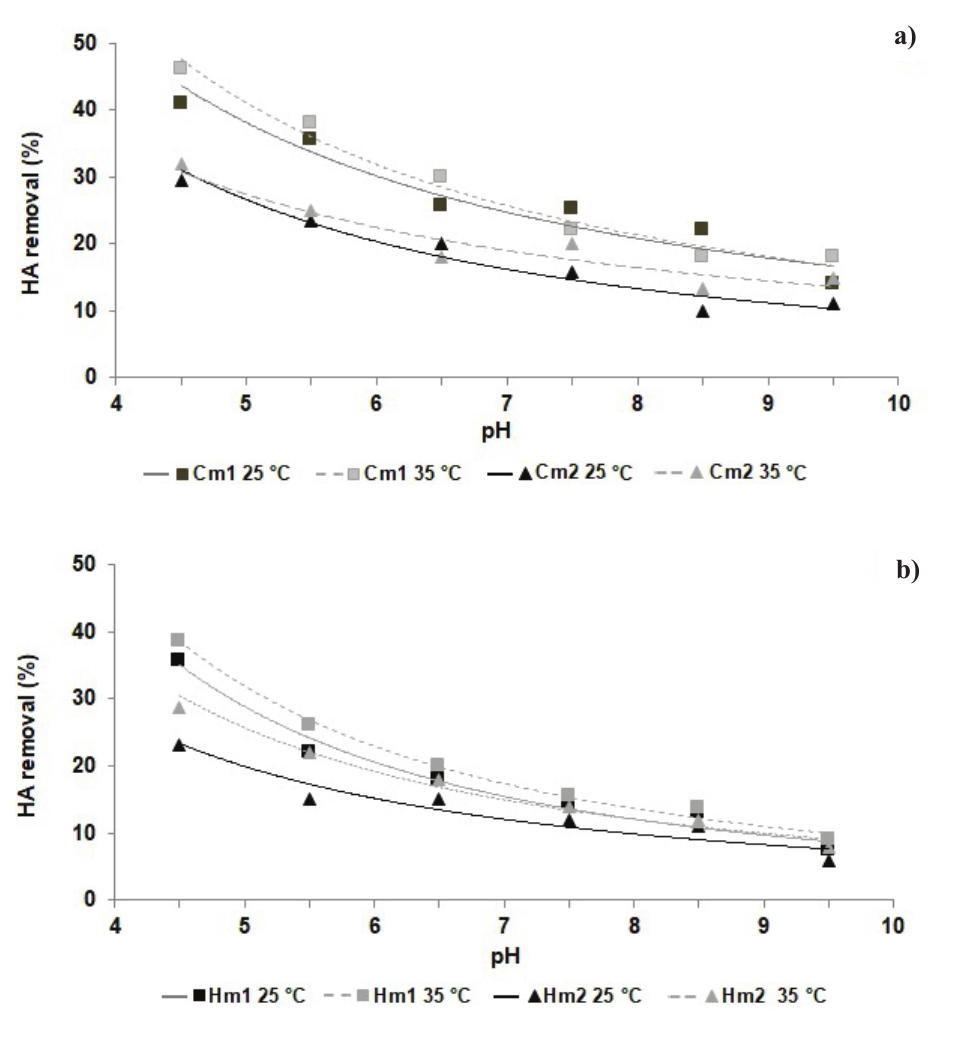
Fig. 5 – Effects of pH on HA removal using (a) Cm1 and Cm2, and (b) Hm1 and Hm2 (γ